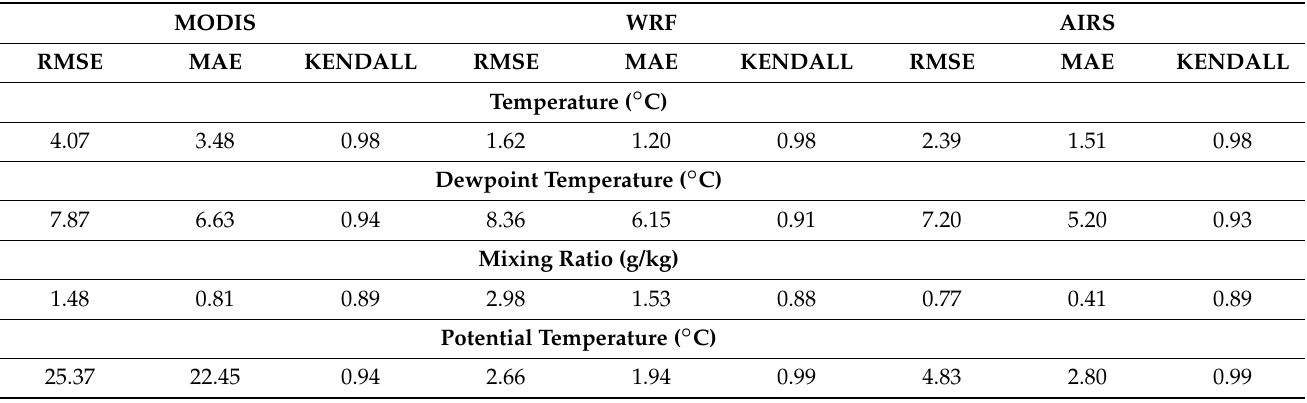
Table 4. Average values of the statistical metrics of drone, MODIS, and WRF profiles for the four variables analyzed up to 15,000